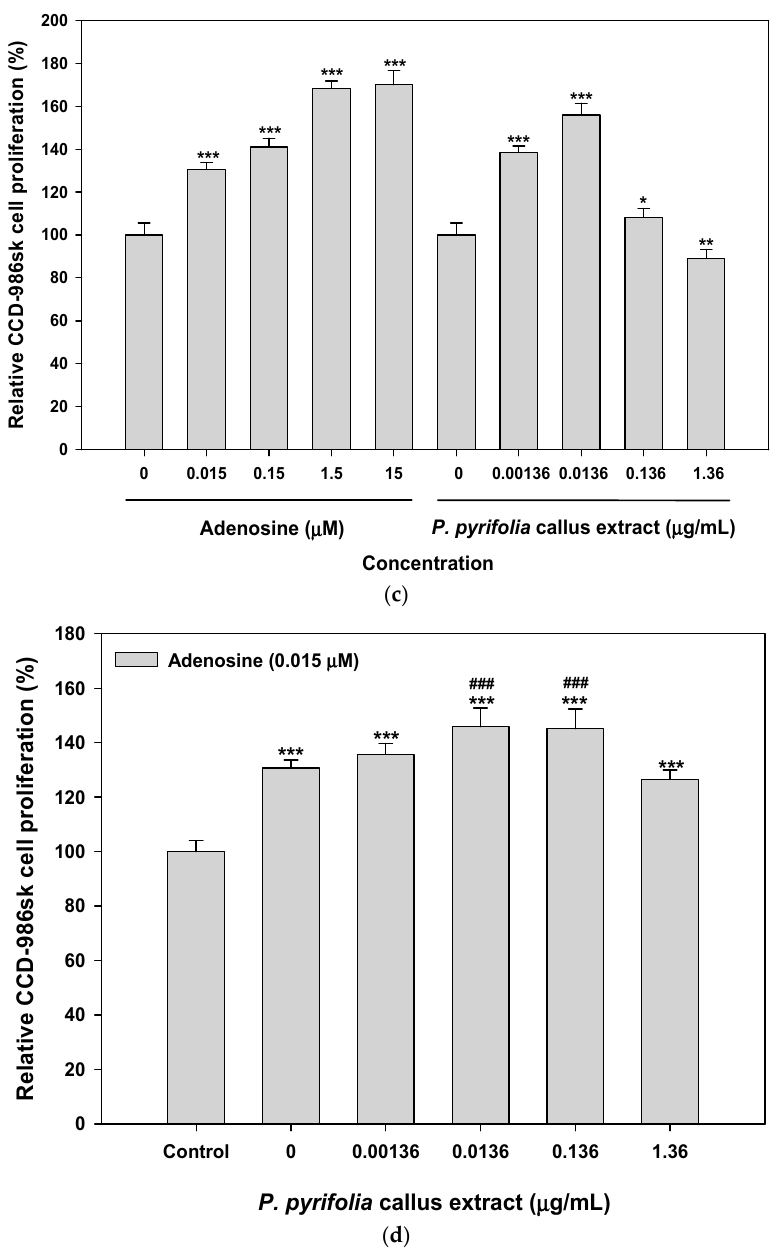
Figure 4. Relative HaCaT cell proliferation after treatment with ( a ) P. pyrifolia callus extract alone or ( b ) in combination with adenosine (0.015 µM). CCD-986sk cell proliferation after treatment with ( c ) P. pyrifolia callus extract alone or ( d ) in combination with adenosine (0.015 µM). Values are means ± standard deviation ( n = 6 per group). * p < 0.05, ** p < 0.01, *** p < 0.001 compared to untreated controls. ### p < 0.001 compared to 0.015 µM adenosine alone.